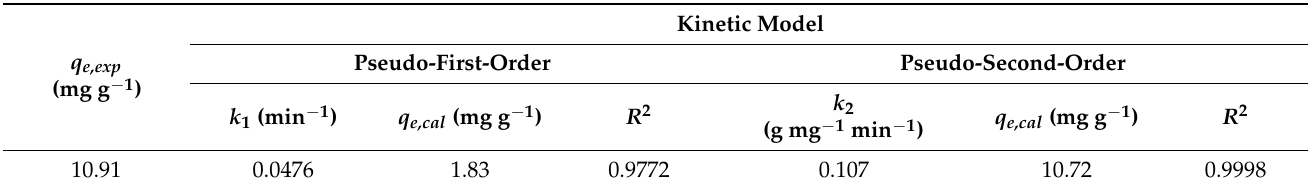
Table 1. The pseudo-first-order and pseudo-second-order sorption models constants of CIP on the ternary core–shell Fe 3 O 4 /SiO 2 /TiO 2 nanocomposite.